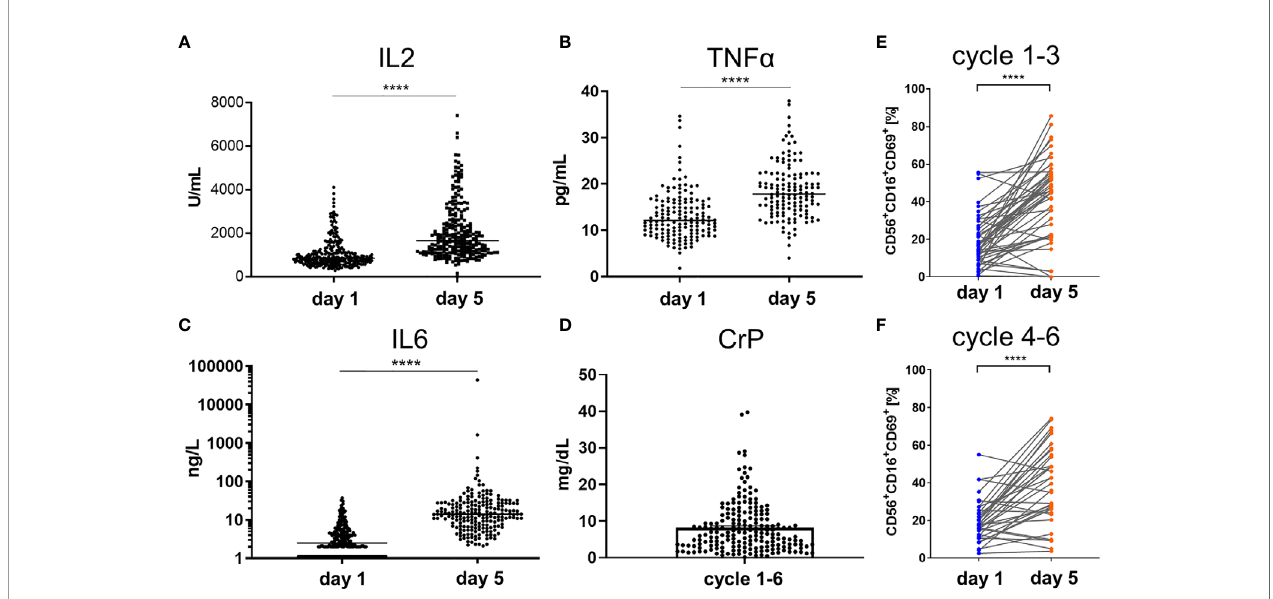
FIGURE 2 | Elevation of proin fl ammatory cytokines and activation of NK cells by ch14.18/CHO antibody infusion therapy. The infusion of ch14.18/CHO induced robust immune response measured by means of secretion of proin fl ammatory cytokines (A) IL2, (B) TNF a , (C) IL6, and (D) CrP in serum of patients or lithium heparin plasma as well as by the percentage increase in number of activated NK cells (E, F) . Cytokines and NK cells were measured on day 1 prior to the start of antibody infusion and on day 5 of cycles 1 to 9. The maximum level of CrP per cycle is shown for the cycles 1 – 6 in (D) . Every single dot represents an independent single value per cycle and patient used from cycles 1 – 6 (A – D) but as indicated in (E) cycles 1 – 3 and (F) cycles 4 – 6. For the comparison of (A) IL2 n = 232, (B) TNF a n = 137, (C) IL6 n = 207 was availablein pair values and for (D) CrP n = 198 single values were used.NKcellimmunophenotype was assessed by fl ow cytometry andwas de fi nedas the CD56 + CD16 + andCD3 − subset of lymphoid cells. The early activation marker CD69 was usedto distinguishresting (CD69 − ) fromactivated(CD69 + ) NK cells n cylces1 – 3 = 47, n cylces 4 – 6 = 36. Statistical analysiswas doneby two-tailed paired t-test. P-values below 0.05 were de fi ned signi fi cant. **** =